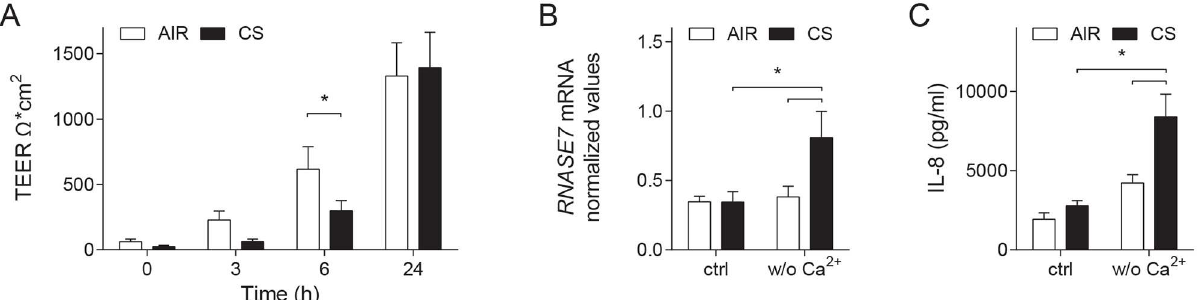
Fig 1. Effects of CS on airway epithelial barrier recovery and innate immunity. Barrier integrity in ALI-PBEC was disrupted using calcium depletion,and cells were subsequently exposed to air or CS. (A) The trans-epithelial electrical resistance (TEER) was subsequently measured at 0, 3, 6, and 24 h after exposure to assess loss and recovery of barrier integrity in air- and CS-exposed cultures. TEER values in ohm ( Ω ). n = 7 independent donors. (B) At 24 h, mRNA expression of RNASE7 was assessed in ALI-PBEC that were incubatedwith calcium-depleted medium (w/o Ca 2+ ) versus control medium (ctrl), and subsequently exposed to either air or CS and further incubatedin calcium containingmedium. NormalizedmRNA expression comparedto RPL13A and ATP5B is depicted in the graph. n = 4 independent donors. (C) Secretion of IL-8 in the basal culture medium was assessed by ELISA. n = 5 independent donors. Data are shown as mean; error bars represent SEM; experiments were conductedusing duplicateexposuresin all donors, * p < 0.05.